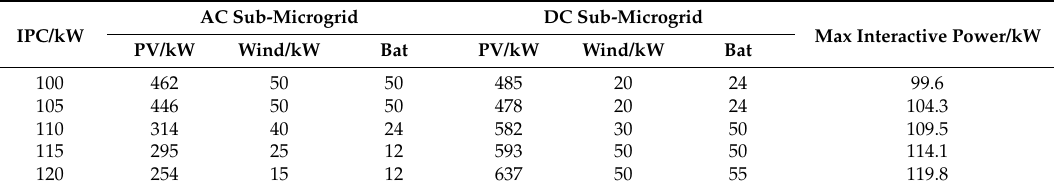
Table 4. Optimization planning results under different interactive power